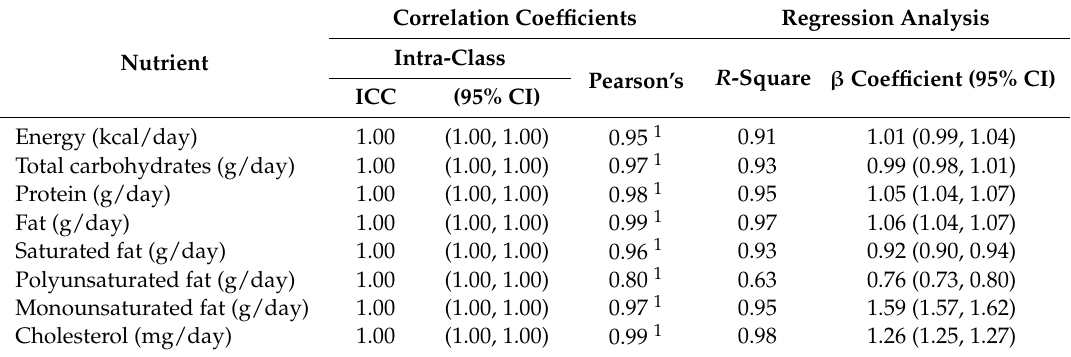
Table 3. Correlation Coefficients and linear regression analyses of recomputed nutrient intakes with those in the original dataset ( n =